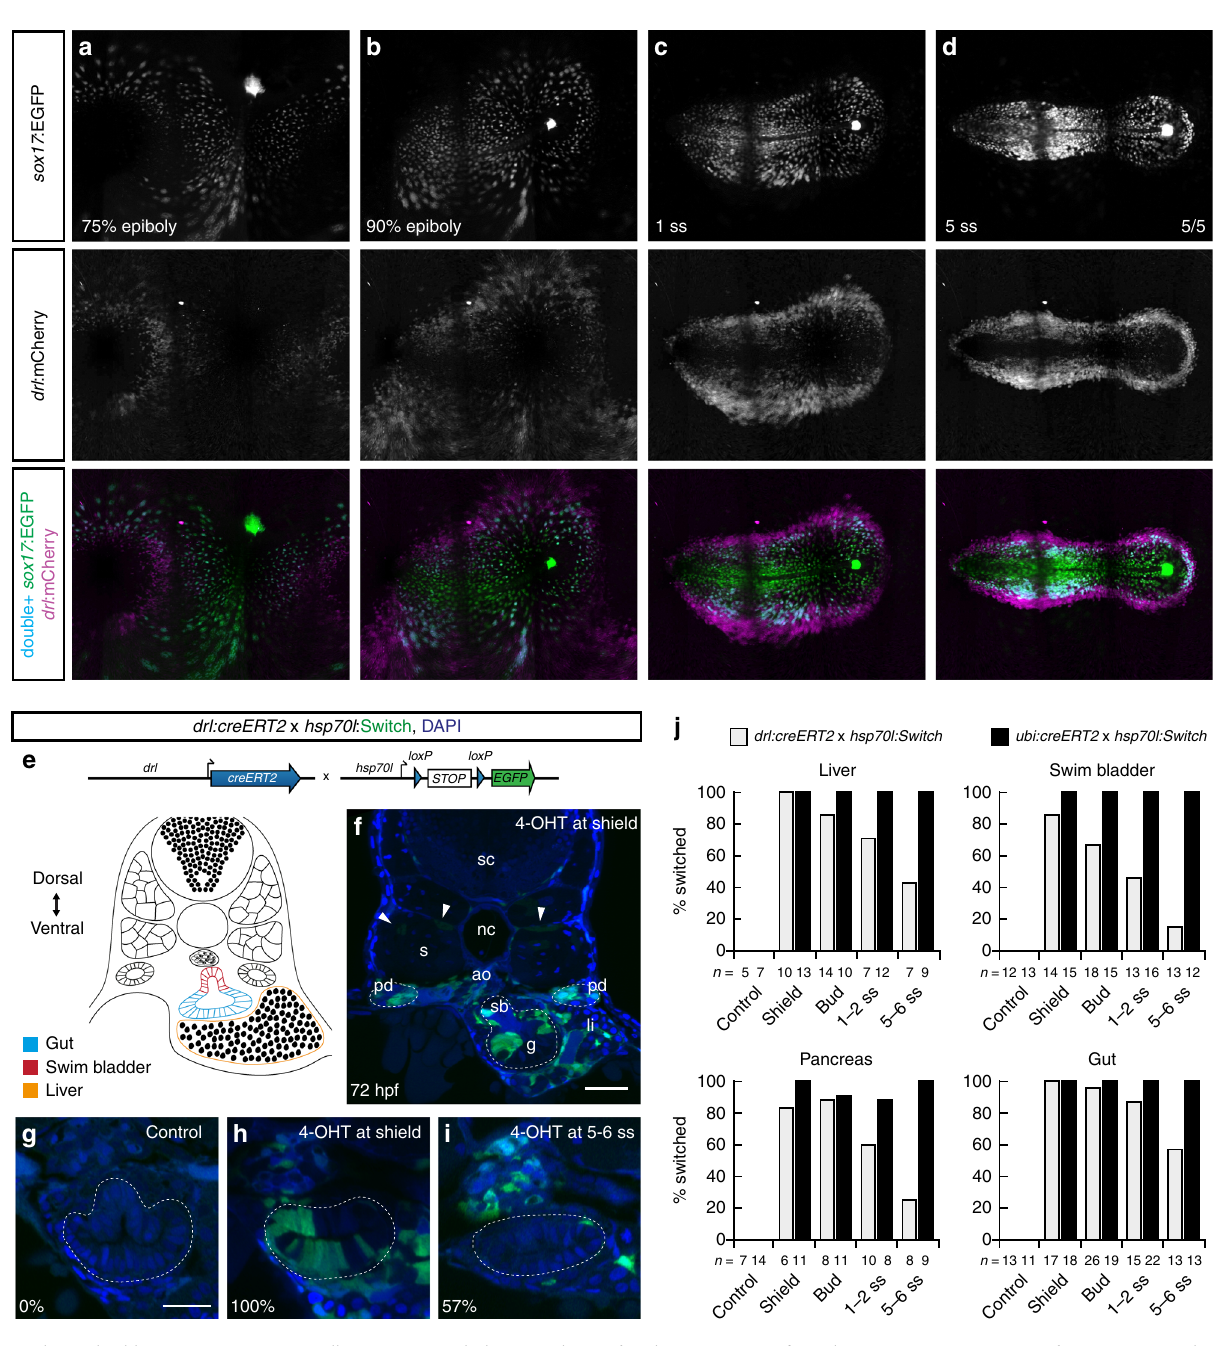
Fig. 2 The early drl reporter-expressing cells comprise endoderm- and LPM-fated progenitor. a – d Single time point projections of sox17:EGFP marking endoderm progenitors ( a – d ) and drl:mCherry marking LPM progenitors from gastrulation until 5 ss; anterior to the left. Double-positive cells for EGFP and mCherry shown in blue ( a – d ) ( n = 5/5). e Schematic of drl:creERT2 to hsp70l:Switch cross for genetic lineage tracing and schematic of transverse section (trunk region) with endoderm- and LPM-derived organs at 3 dpf. f Representative 72 hpf transverse section of drl lineage-traced embryo 4-OHT-induced at shield stage; arrowheads depict rare trunk muscle labeling. g – i Representative transverse sections of drl lineage tracing at 72 hpf, control ( g ) versus 4- OHT-induced at shield stage ( h ), and 5 – 6 ss ( i ); note gradual loss of endoderm labeling (intestinal cells, dashed region). Numbers indicate percentage of embryos with intestinal lineage labeling. j Quanti fi cation of endoderm lineage labeling in representative organs following 4-OHT induction at indicated time points, comparing drl:creERT2 versus ubiquitous ubi:creERT2 control as reference for the hsp70l:Switch lineage reporter. N-numbers are mentioned in the graph legends. Notochord (nc), somite (s), spinal cord (sc), pronephric duct (pd), liver (li), swim bladder (sb), gut (g), nuclei in blue (DAPI; f – i ). Scale